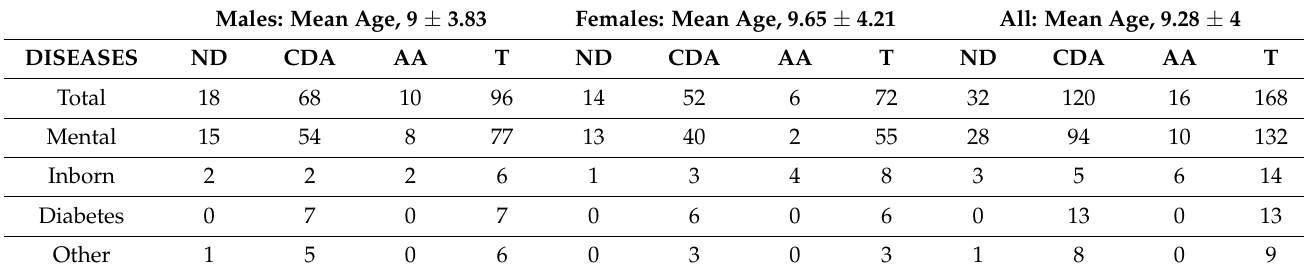
Table 5. Iglesias: civil invalidity in subjects under 18 years old in 2021 (January–September). Males: Mean Age, 9 ± 3.83